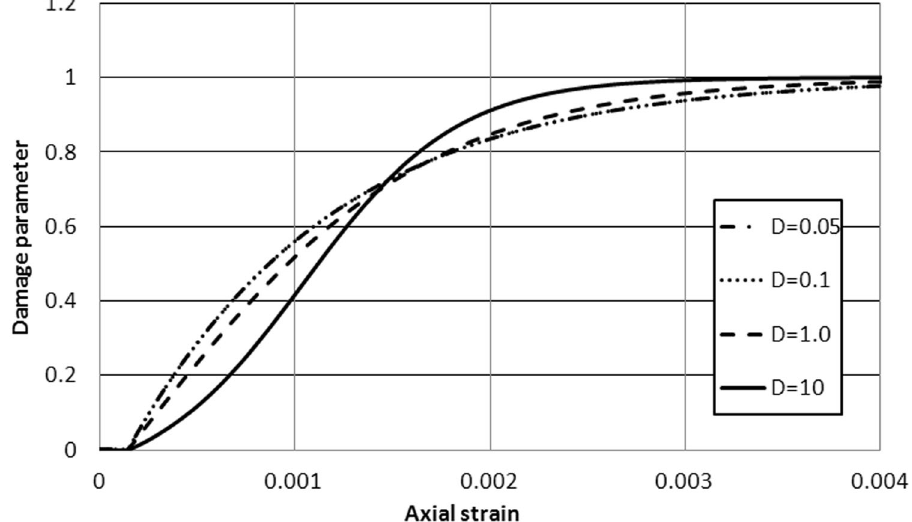
Fig. 8 Tensile damage evolution of CSCM.